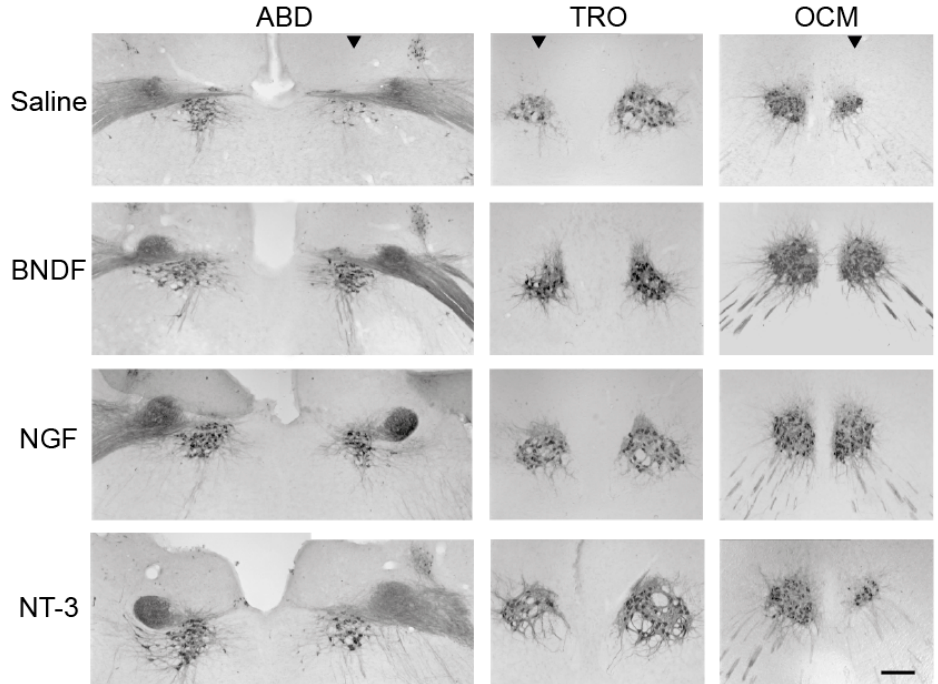
Figure 4. ChAT immunoreactivity in extraocular motoneurons 10 days after right eye enucleation at P0 and different neurotrophic treatments from the orbit via a Gelfoam implant. Note the remarkable reduction in cell death in the different axotomized extraocular motor nuclei, as compared with the saline treatment, after the administration of BDNF, NGF or NT-3. BDNF and NGF, but not NT-3, also prevented the downregulation in ChAT in the lesioned motoneurons of the abducens (ABD), trochlear (TRO) and oculomotor (OCM) nuclei. Arrowheads indicate the affected side for each nucleus after the unilateral enucleation. Calibration bar: 200 µm. Modified from [114].